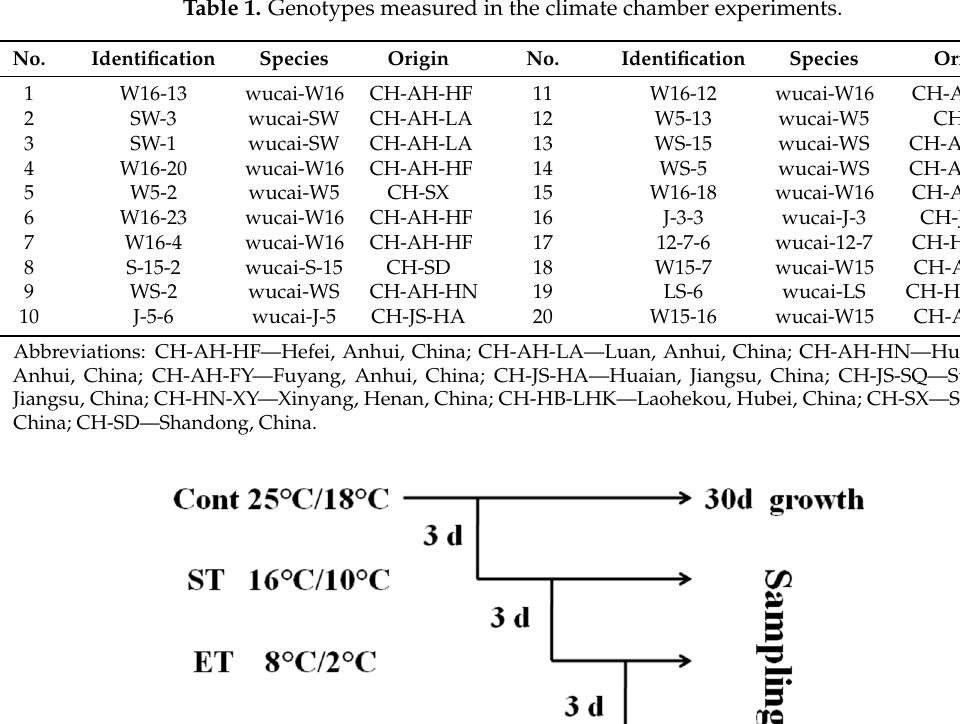
Table 1. Genotypes measured in the climate chamber experiments.